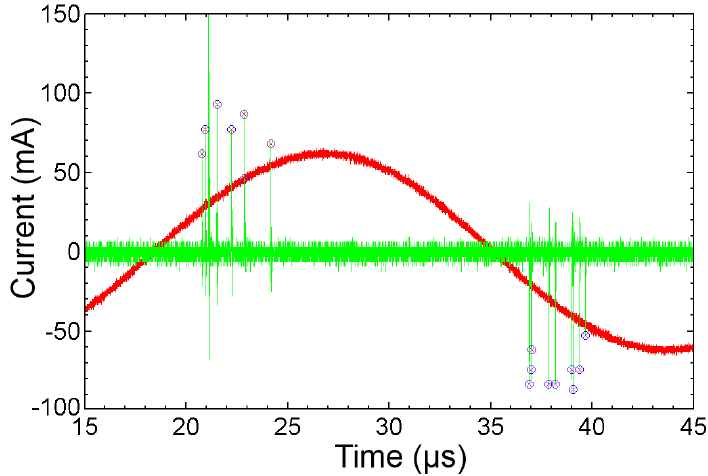
Figure 5 : Example of discharge current waveform (green) processing: identified microdischarges (marked with crossed circles) are given together with the corresponding voltage waveform (red) to show current/voltage phase